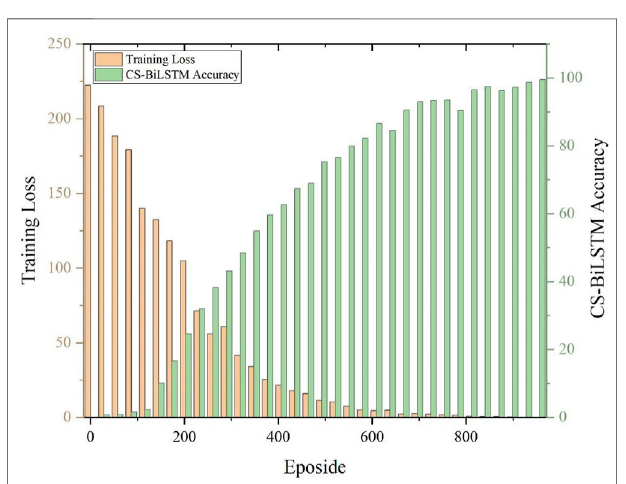
FIGURE 9 | Comparison of training